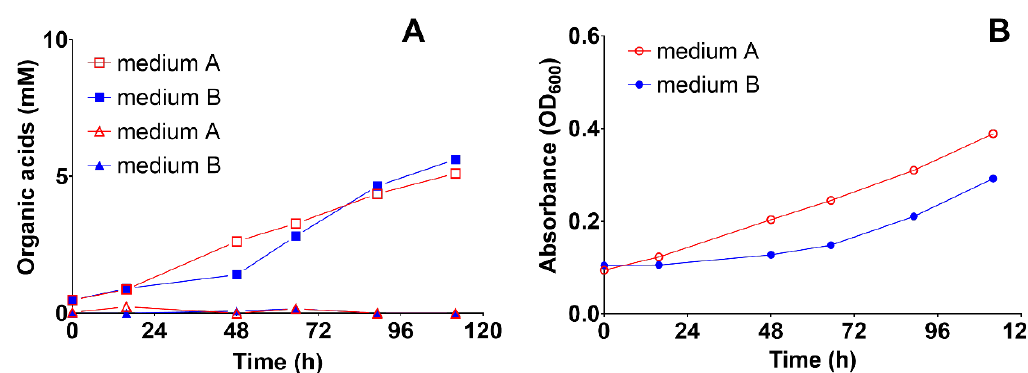
Figure 4. The e ff ect of yeast extract on the production of acetic and formic acid and biomass during autotrophic feeding with H 2 / CO 2 (80:20) in a 1-L bioreactors with medium A (containing 0.2 g L − 1 yeast extract) and medium B (free of yeast extract but containing vitamins). Both media were reduced with cysteine-HCl. ( A ) Acetic acid and formic acid concentration profiles during the first batch cycle, and ( B ) microbial biomass growth, as measured by optical density at 600 nm during the first batch cycle. The experiments were conducted in two biological replicates with orbital shaking at 200 rpm. Each data point depicts the median and the range (invisible error bars are smaller than the symbol). Square: acetic acid, triangle: formic acid, circle: biomass.